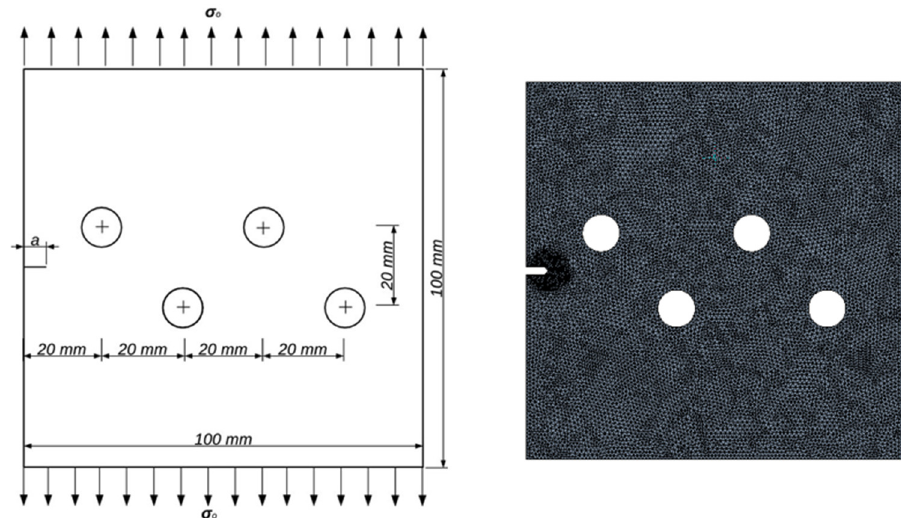
Figure 10. Geometrical dimensions ( left ) and its initial adaptive mesh ( right ).